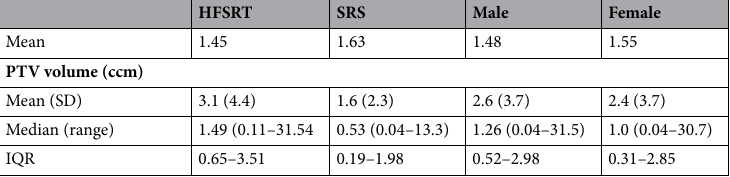
Table 1. Patient characteristics.